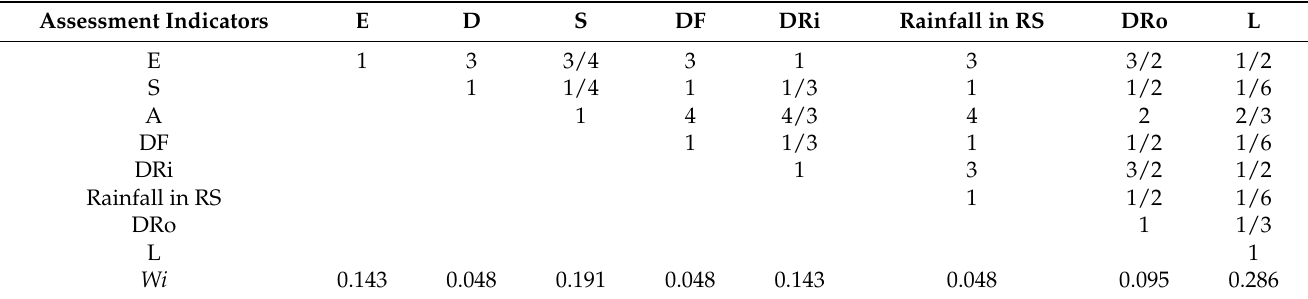
Table 5. Judgment matrix of the weight of assessment indicators during RS.